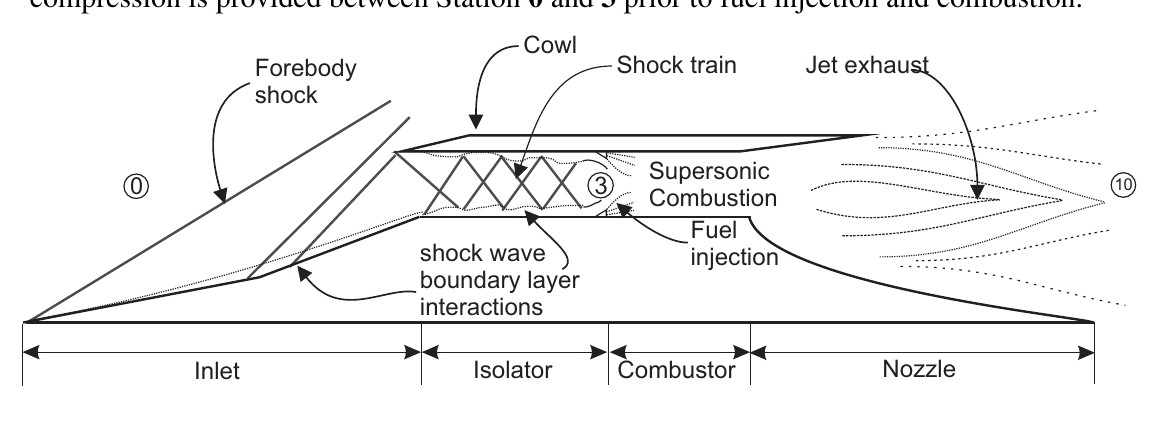
Figure 1. Generic schematic of a scramjet engine working principle where, typically, compression is provided between Station 0 and 3 prior to fuel injection and